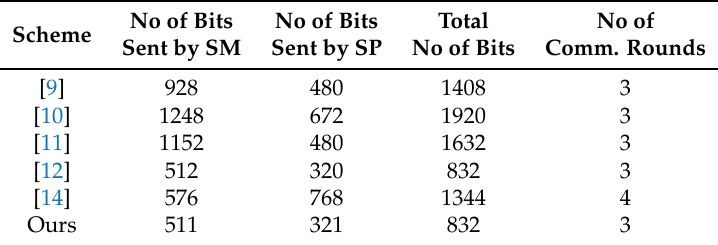
Table 4. Comparison of communication